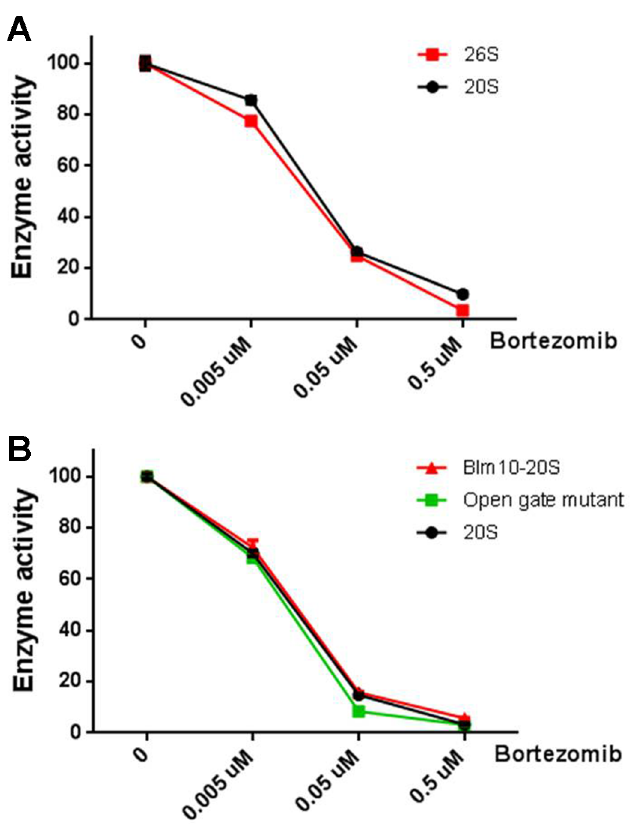
Figure 10. Effect of bortezomib on the chymotryptic-like activity of different forms of the proteasome from yeast. Purified 20S subunit, Blm10-20S, open gate mutant of the 20S subunit and 26S were combined with the indicated concentrations of bortezomib in the presence of substrate. After incubation for 15 minutes, enzyme activity was measured by monitoring the fluorescence kinetics for the next 30 minutes. Panel A represents inhibition of 26S and 20S by bortezomib in the presence of buffer containing ATP. Panel B represents inhibition of Blm10-20S, the open gate mutant and 20S by bortezomib in the presence of buffer without ATP. Enzyme activity is expressed as percent control without inhibitor. Error bars show standard error of the mean; error bars smaller than symbol size are not visible.